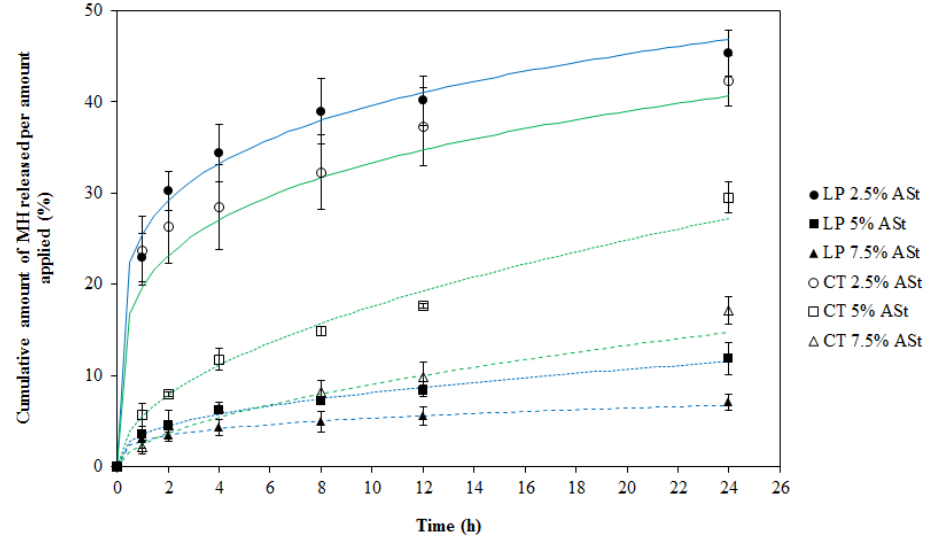
Figure 1. Release profiles and fitting curves of Korsmeyer–Peppas model for MH from MHASt-emulsions through Tuffryn ® membrane in water at 37 ◦ C (mean ± SD, n = 6). LP—MHASt-emulsions with LP; CT—MHASt-emulsions with CT.